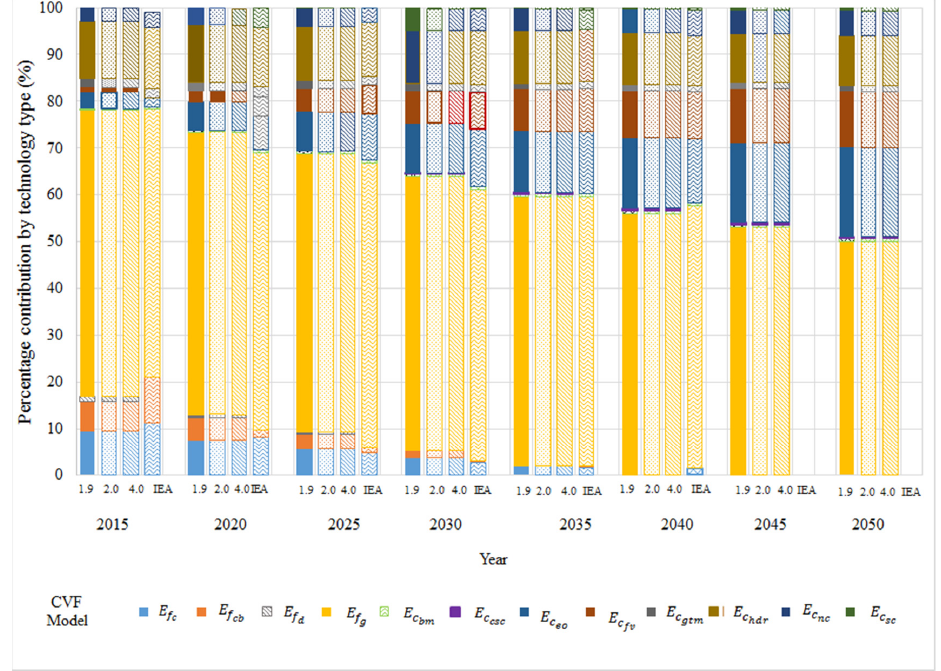
Figure 24. CVF Energy superstructure scenario satisfying governmental objectives from GCCL and NCCS [11,12] compared with IEA scenarios. Prepared by the authors based on own results and public data from cited Reference